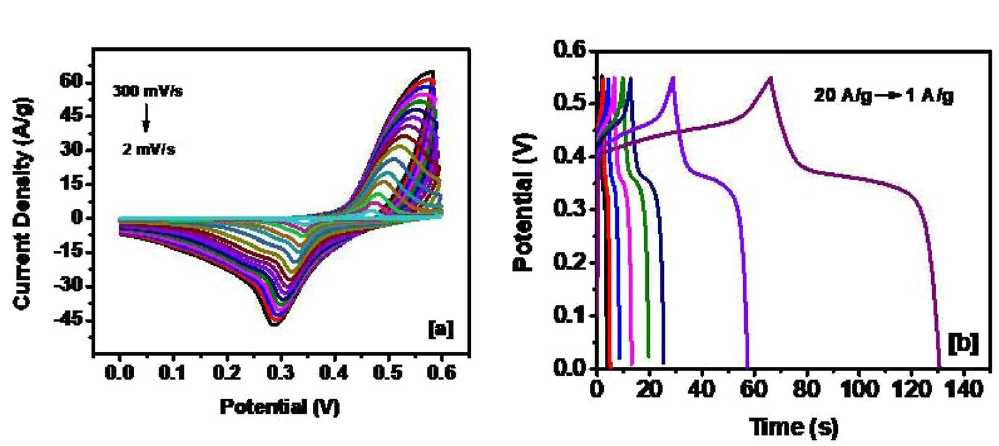
Figure 7. ( a ) CV curves at various scan rates ( b ) Galvanostatic charge and discharge curves, for NiS sample synthesized from the complex (2) at 250